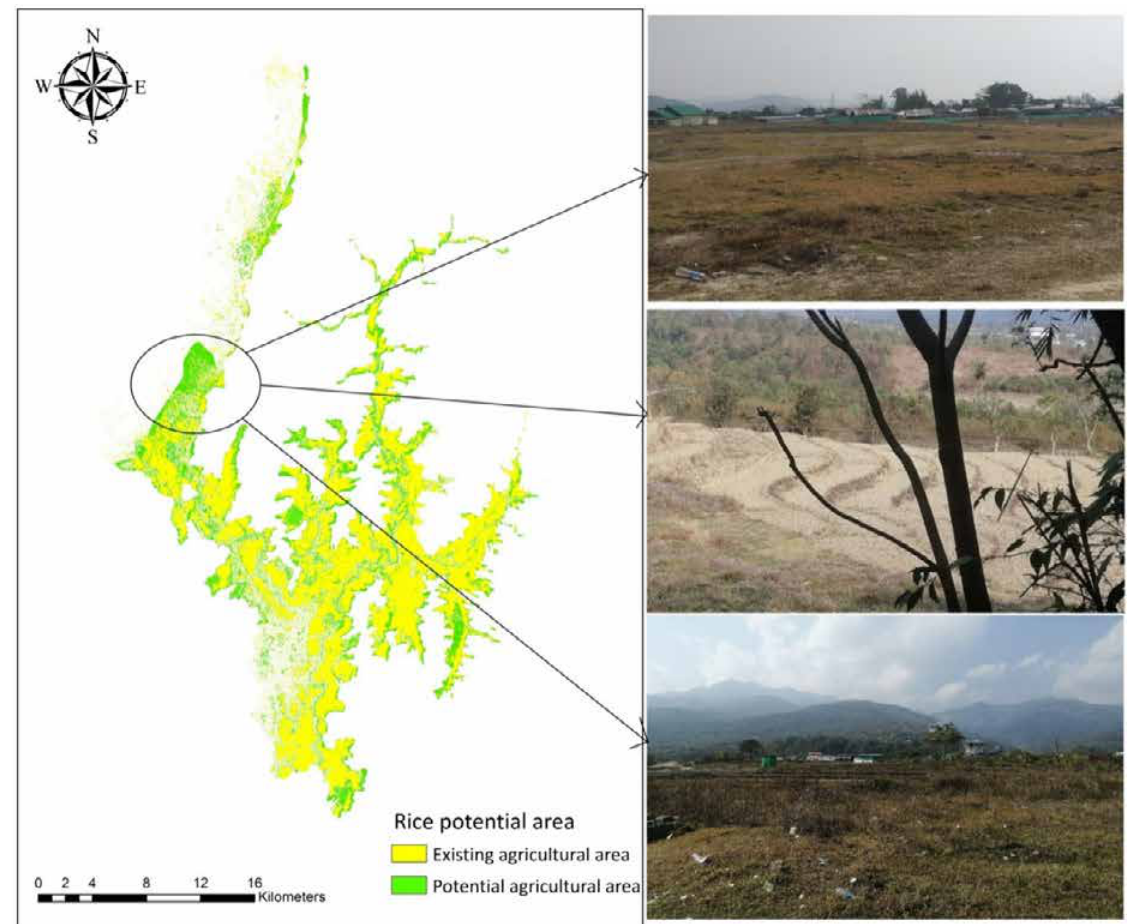
Fig. 5: Potential area for rice cultivation along with the field photographs